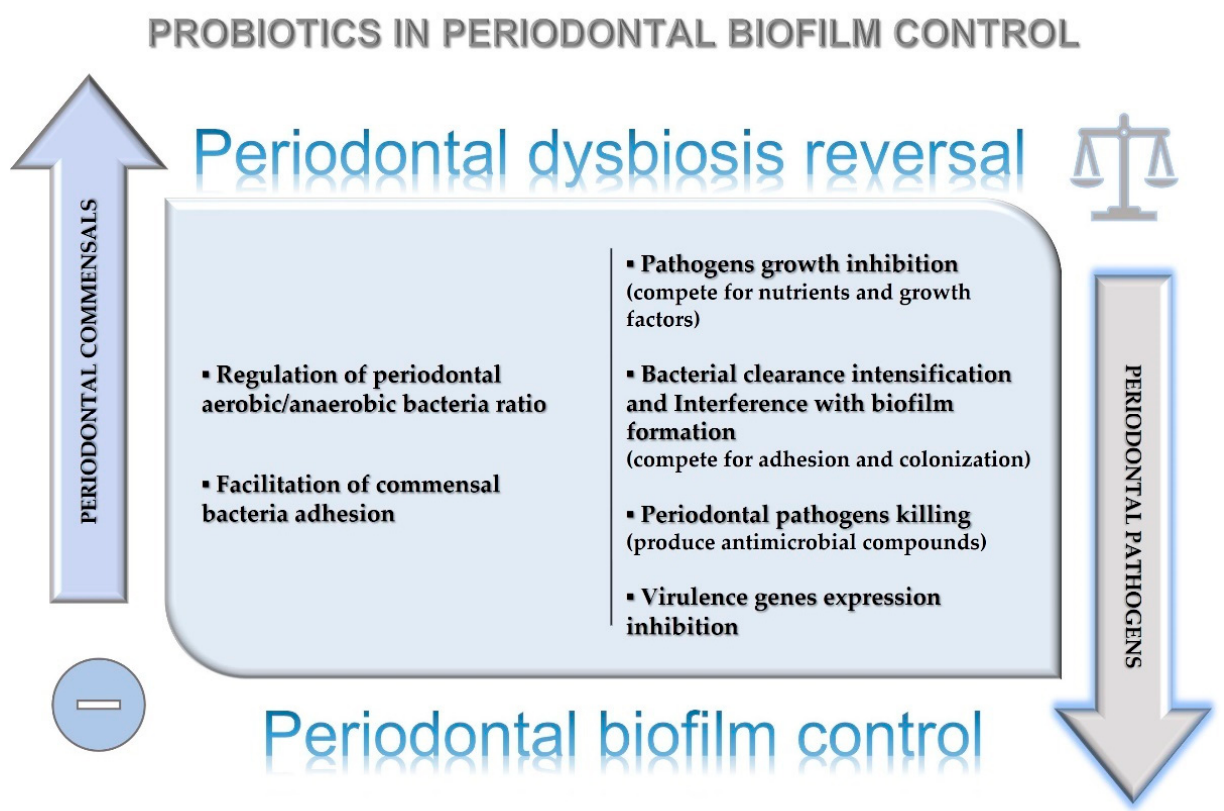
Figure 1. Putative probiotics’ effect on periodontal dysbiosis reversal and biofilm control in perio- dontal health management.